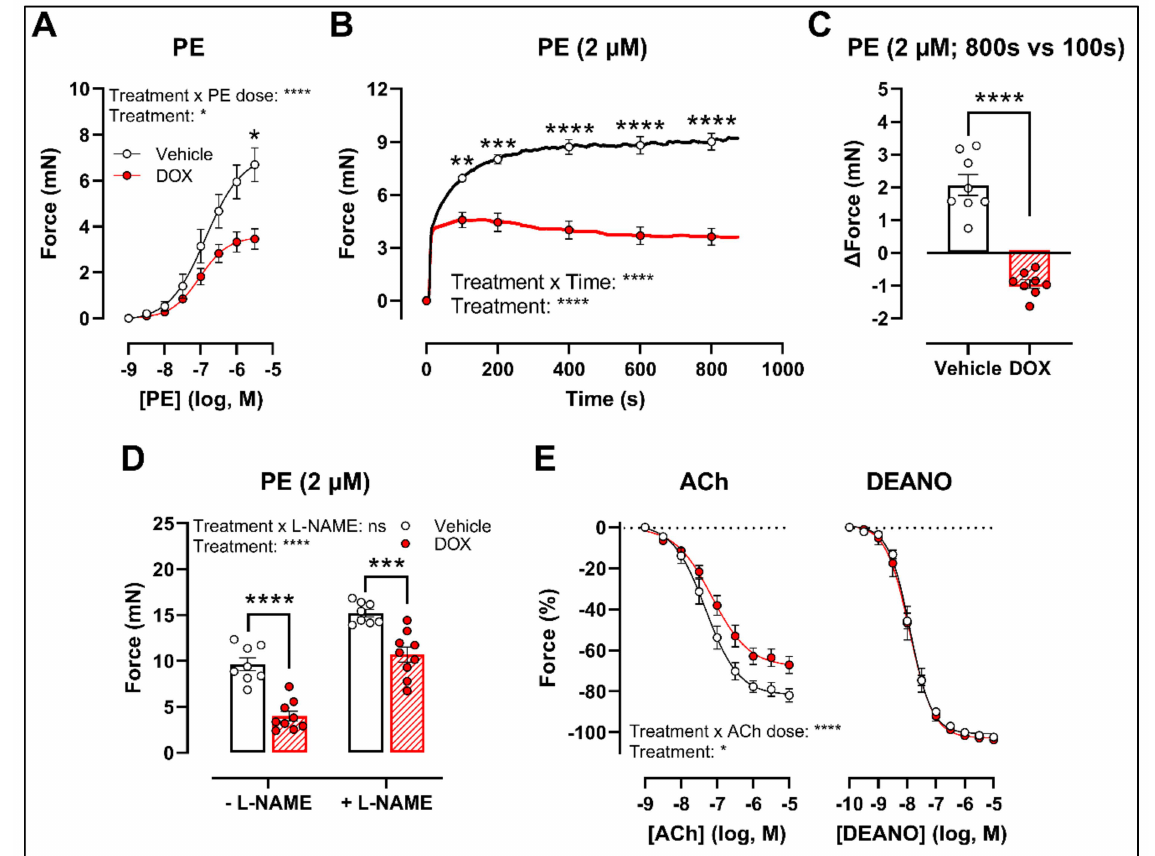
Figure 2. VSMC contraction and relaxation in aortic segments after 16 h of ex vivo DOX treatment. Following 16 h of ex vivo DOX treatment, VSMC contraction was decreased in response to PE ( A , B ). In the DOX-treated aortic segments, there was a lower increase in force between 800 s and 100 s ( C ). The DOX-induced decrease in contraction was still observed in the presence of L-NAME ( D ). ACh-induced relaxation, but not DEANO-induced relaxation, was impaired in response to DOX ( E ). For ( A , B , E ), repeated measures two-way ANOVA with Šid à k’s multiple comparisons test. For ( C ), unpaired t -test. For ( D ), two-way ANOVA with Tukey’s multiple comparisons test. *, **, ***, **** p < 0.05, 0.01, 0.001, 0.0001; n = 8 for vehicle group and n = 9 for DOX